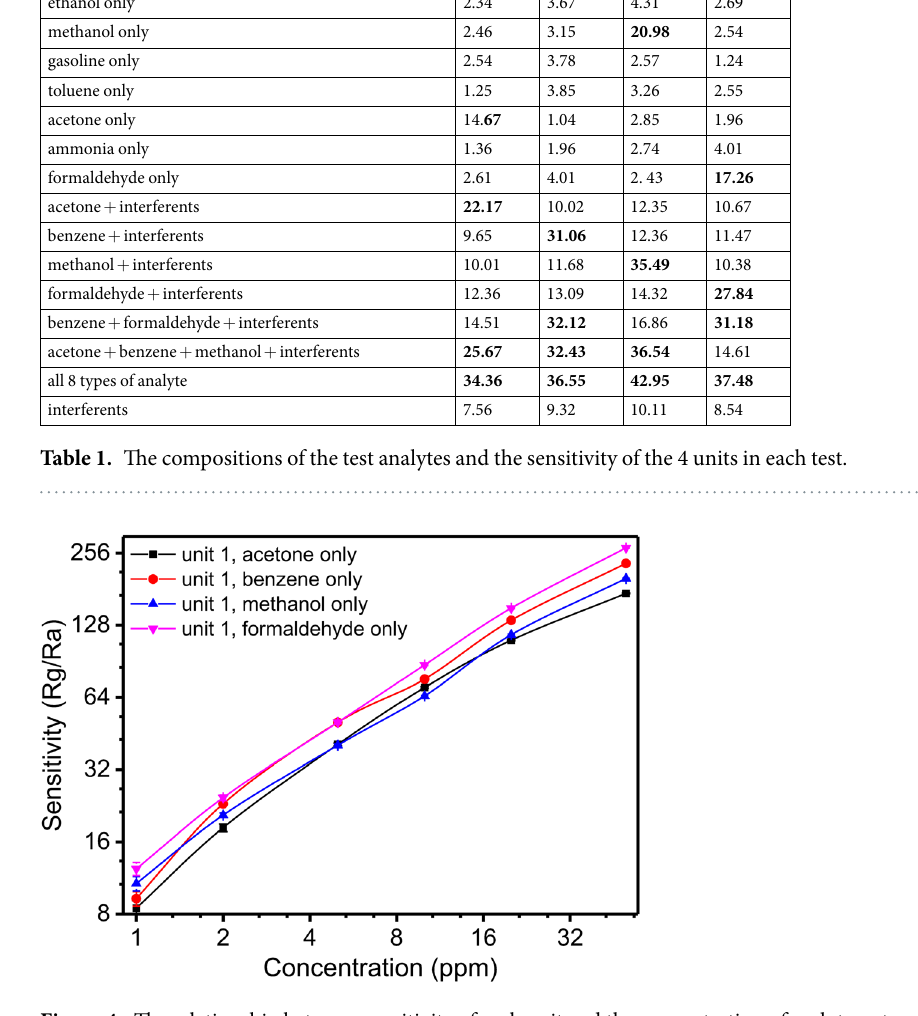
Figure 4. The relationship between sensitivity of each unit and the concentration of each target